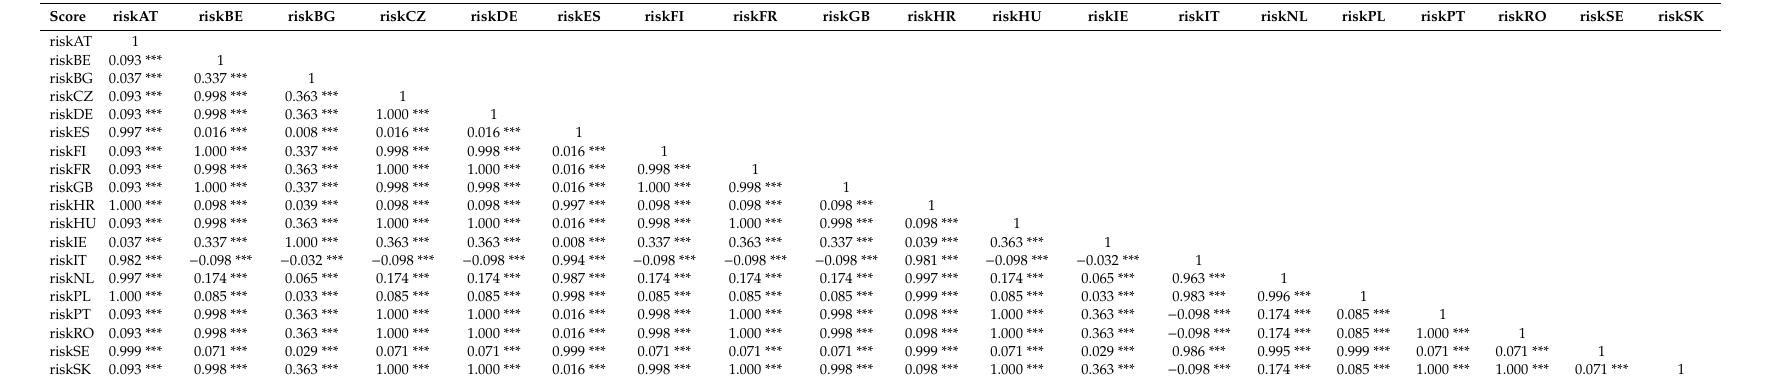
Table 5. Pearson correlation values among scoring PCA bankruptcy risk variables obtained by country.